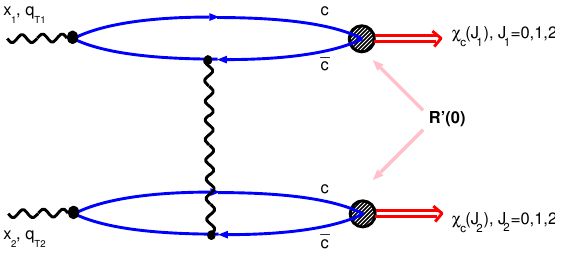
Figure 5. The single gluon exchange mechanism for χ c χ c -pair